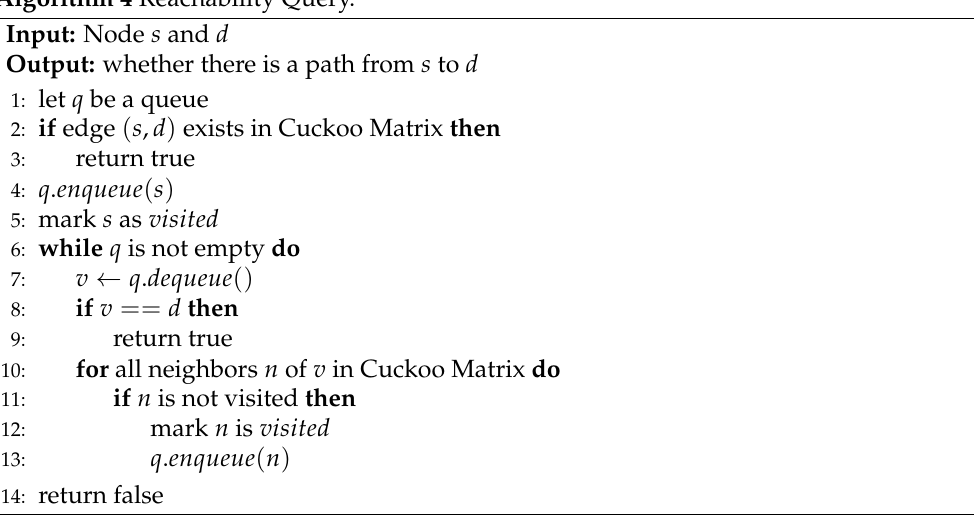
Algorithm 4 Reachability